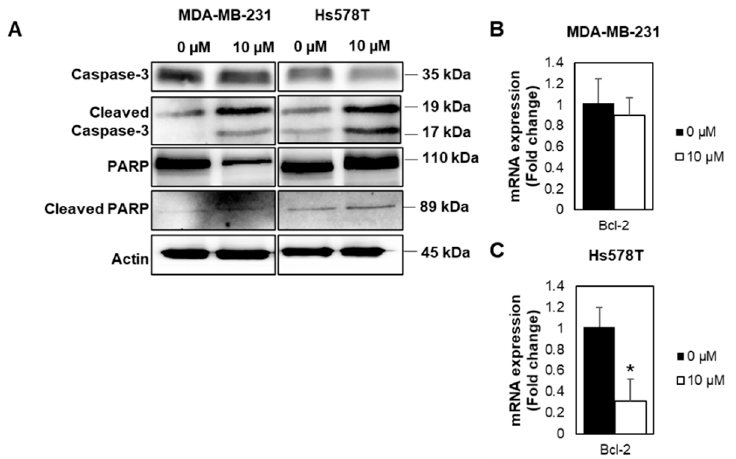
Figure 7. FDI-6 promotes Caspase-3 activation, cleavage of PARP, and Bcl-2 expression. ( A ) Image from the Western blot analysis of HS578T and MDA-MB-231 cells after being treated with 0 and 10 µM FDI-6; ( B , C ) The relative Bcl-2 mRNA expression level of the treated ( B ) MDA-MB-231 and ( C ) Hs578T cells in comparison with the control were determined by qRT-PCR and were normalized against L19, the house keeping gene. The bar graphs represent the average of three independent experiments ± S.D. ( n = 3). Statistical significance was determined by Student’s t -test (not significant, ns; significant, * p <